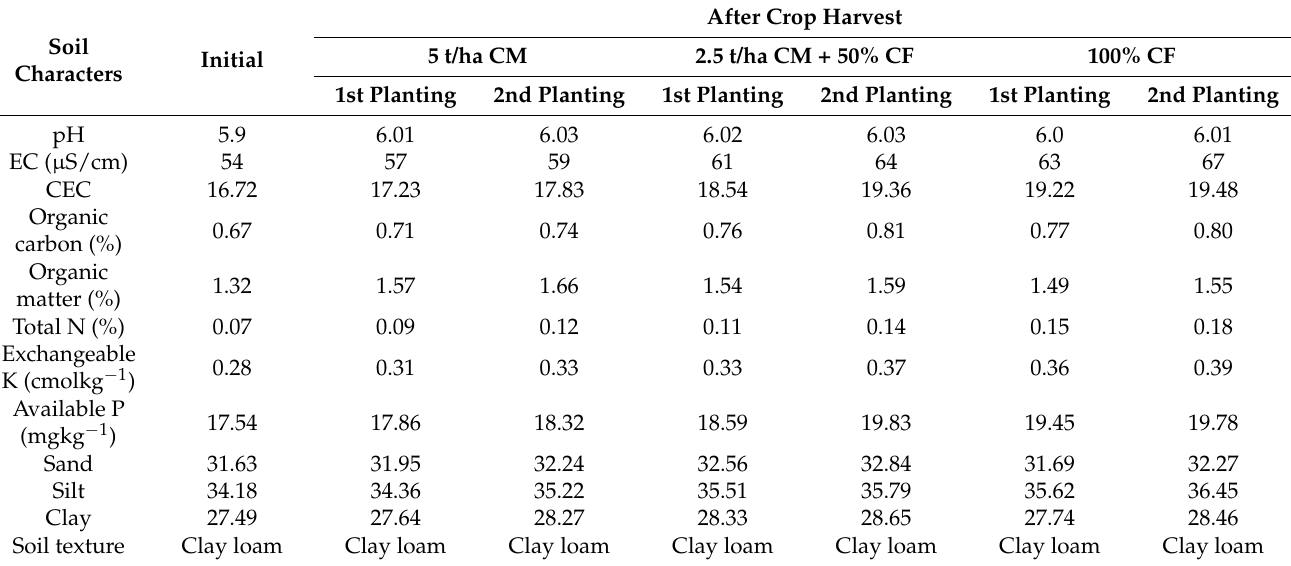
Table 3. Physiochemical characteristics of the initial and postharvest soil sample at the pot experiment on over two planting seasons,